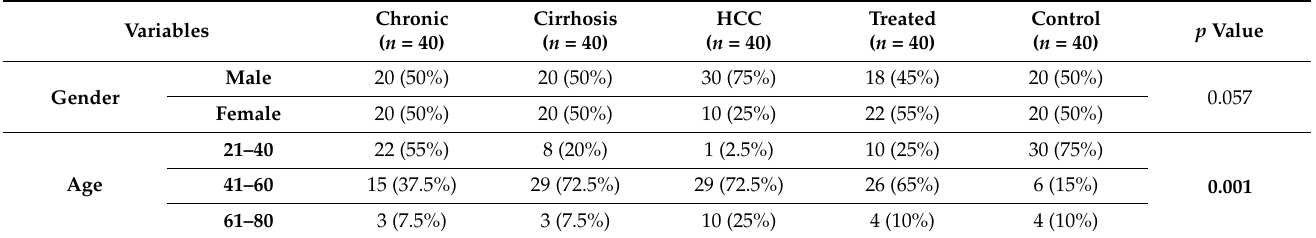
Table 2. Frequency distribution of all demographics for the patients and control subjects.